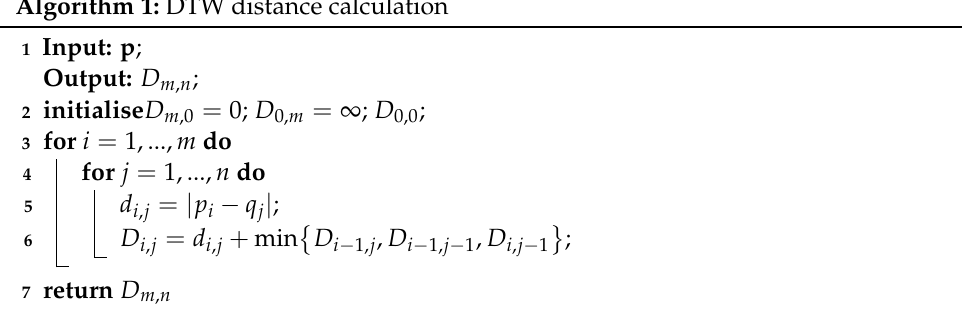
Algorithm 1: DTW distance